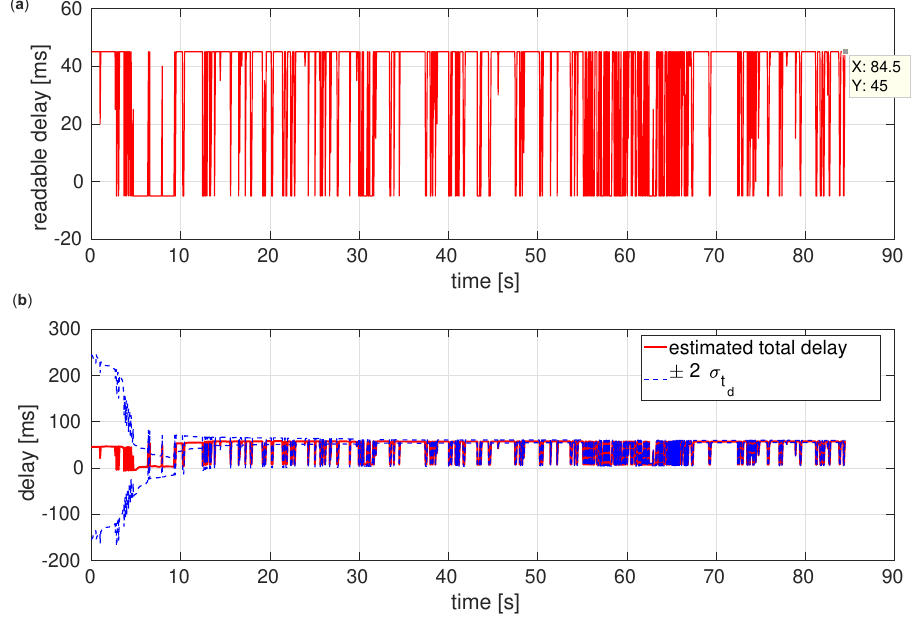
Figure 13. Estimation of time delays of the EuRoC V1 medium dataset. ( a ) Readable delays, ( b ) Estimated total